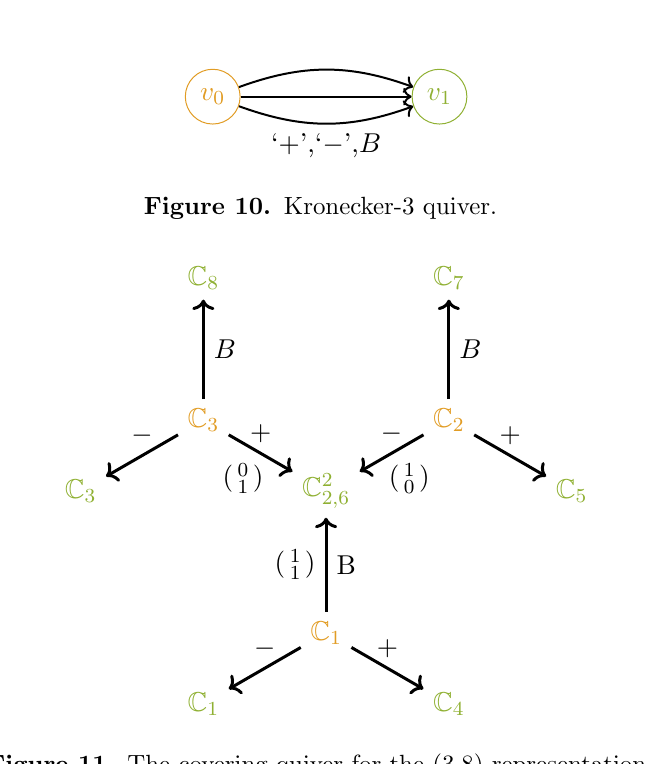
Figure 11. The covering quiver for the (3,8)